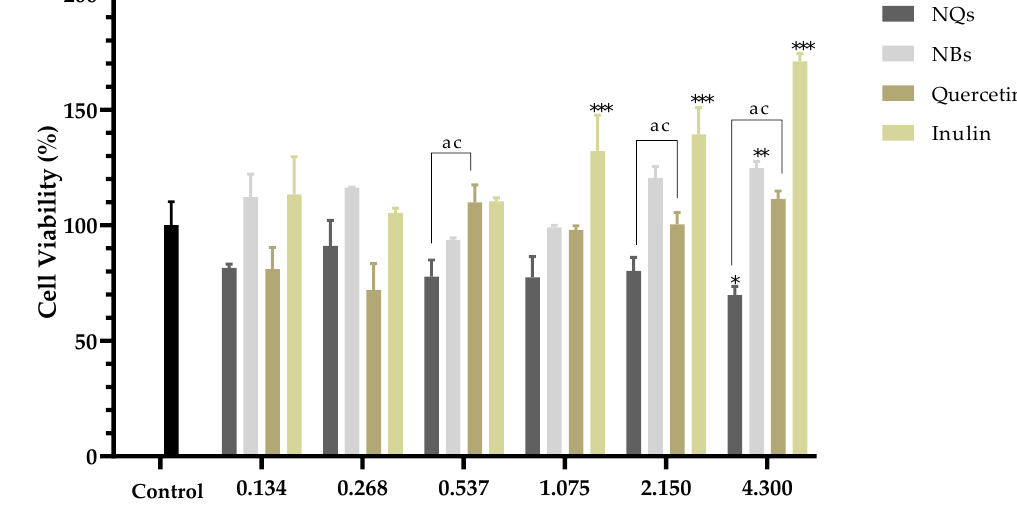
Figure 12. Cell viability in hepatocellular carcinoma (HepG2). Cell viability (%) of inulin nanopar- ticles loaded with quercetin (NQs), inulin non-charged nanoparticles (NBs), quercetin and inulin at different concentrations (4.3 to 0.134 µ g/mL) in hepatocellular carcinoma (HepG2) after 24 h determined using the MTS assay. Values are expressed as mean ± SD. Controls are untreated cells. Significant differences among treatments in the cell lines were determined based on Dunnett multiple comparison test ( p ≤ 0.05) where * represents control vs. NQs, ** represents control vs. quercetin and *** represents control vs. inulin. Significant differences were determined based on the student’s t- distribution ( p ≤ 0.05) where ac represents NQs vs. quercetin. HDFa is a human dermal fibroblast cell line; this was examined by the MTS test and was determined after 24 h of incubation of cells with NQs, NBs, quercetin and inulin. As shown in Figure 13, NQs showed greater than 70% cell viability, on average, at all tested doses (0.268 –4.3 μg/mL). In contrast, quercetin showed a significant difference with NQs at concentrations of 1.075 to 4.3 μg/mL, where HDFA cells treated with NQs showed higher viability than HDFa cells tested with quercetin. On the other hand, NBs and free inulin did not show a toxic effect with around 80% and 70% cell viability, respectively, at all concentrations.